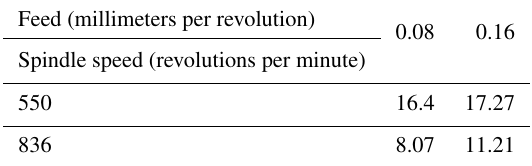
Table 1. Durability